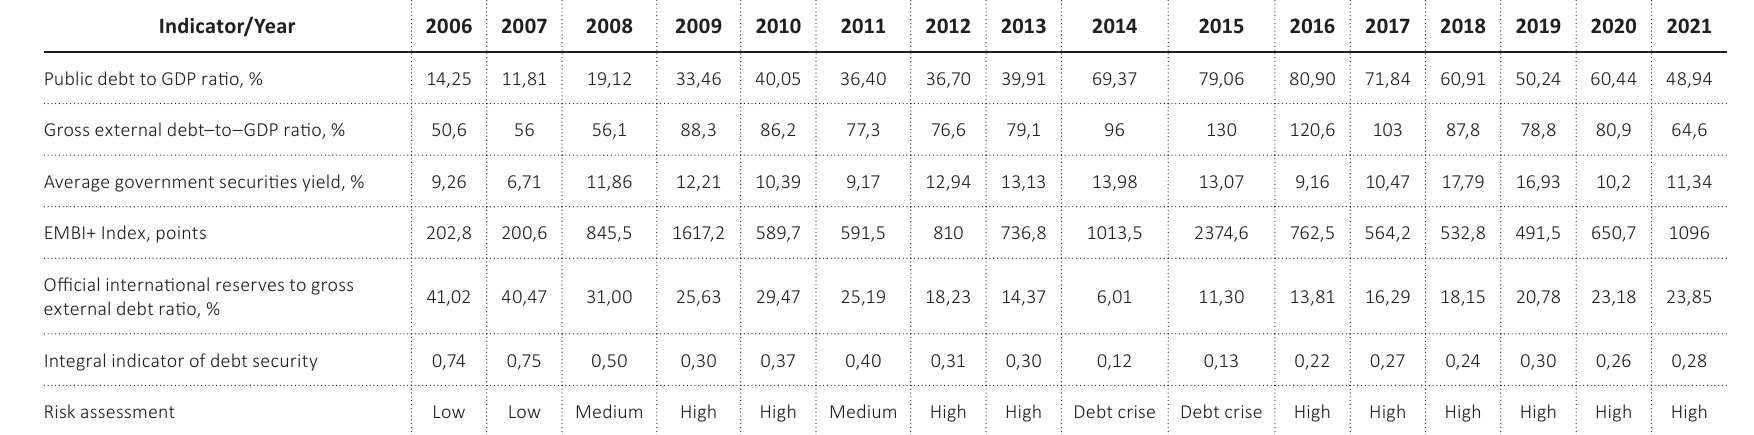
Source: Authors’ compilation and calculation based on the methodology of the Ministry of Economy of